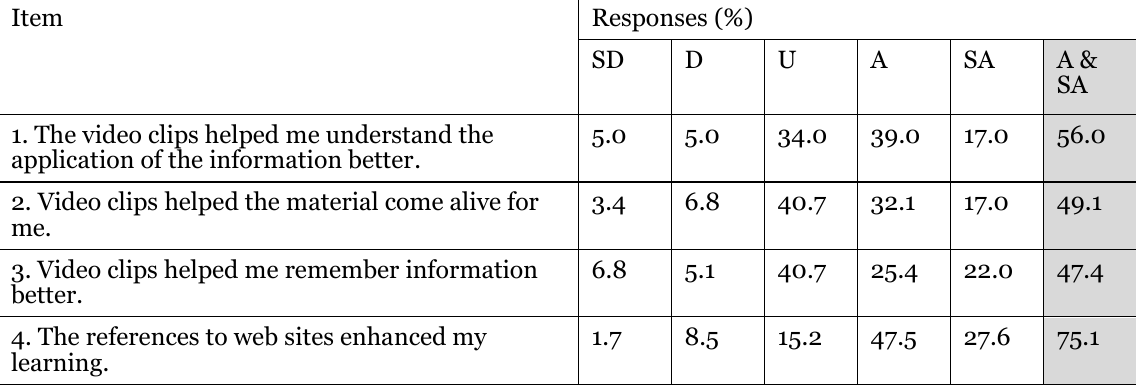
Items Relating to Video Clips and Web